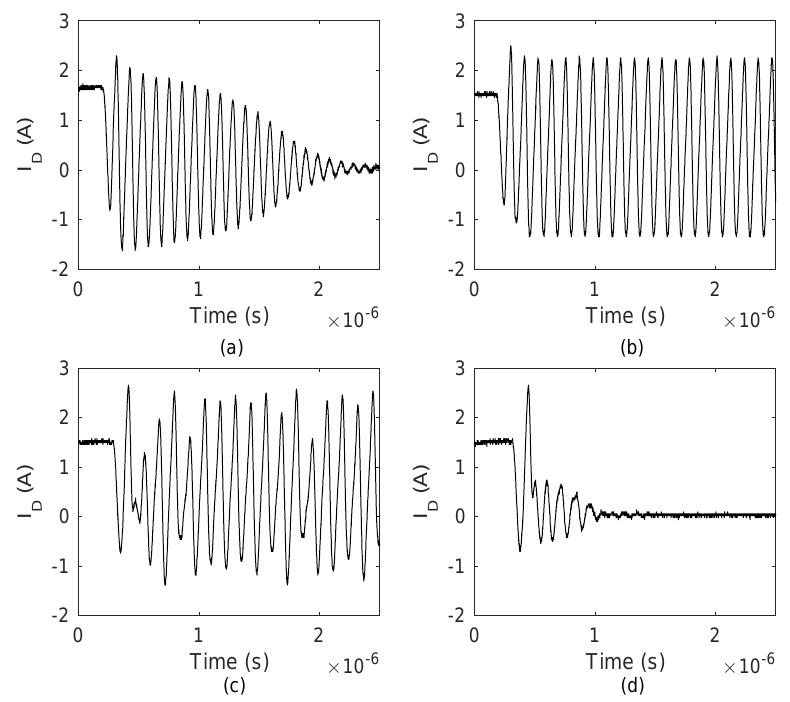
Figure 19. The experimental type II oscillation waveforms of the drain current I D with L C = 650 nH and R G = 1.5 Ω . ( a ) L G = 22 nH. ( b ) L G = 41 nH. ( c ) L G = 68 nH. ( d ) L G = 82